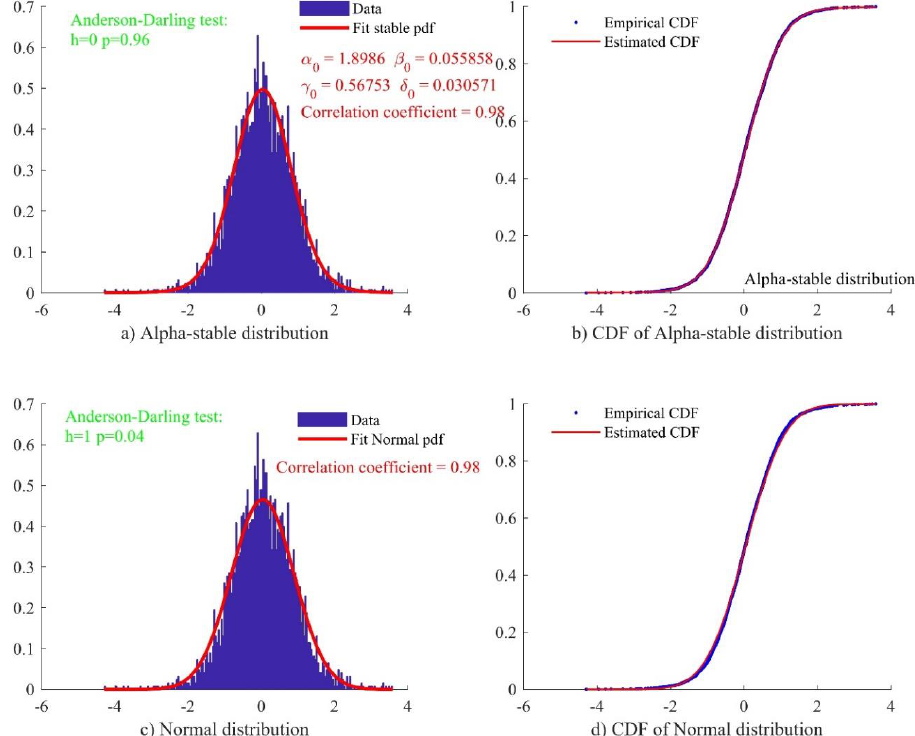
Figure 8. Probability density functions and cumulative distribution function of north-direction time series at ACSO GPS station (N coordinate). ( a ) Residual time series with alpha-stable distribution; ( b ) cumulative density function of residual time series and alpha-stable distribution (correlation; alpha = 0.98); ( c ) residual time series with normal distribution; ( d ) cumulative density function of residual time series and normal distribution (correlation; norm = 0.98).